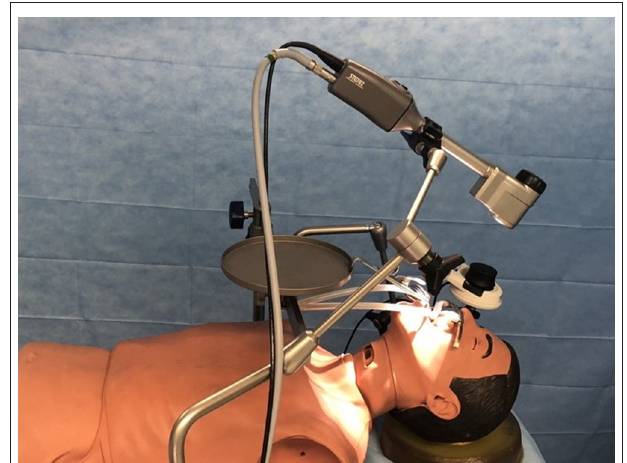
FIGURE 3 | Tests on the